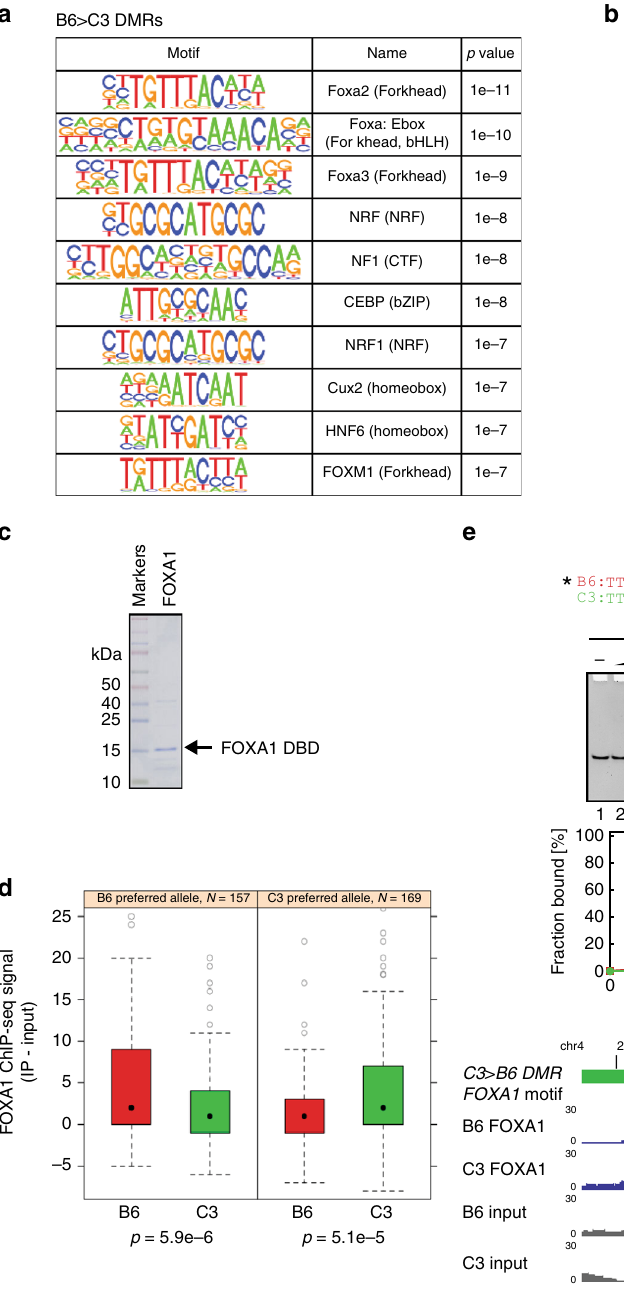
Fig. 4 SNVs at DMRs affect DNA-binding activity of a tissue-speci fi c transcription factor. a Top 10 enriched TF motifs in B6 > C3 DSS DMRs (after expanding DMR size to a minimum of 401 bp) according to HOMER v4.9.1. b Top 10 enriched TF motifs in C3 > B6 DSS DMRs (after expanding DMR size to a minimum of 401 bp) according to HOMER v4.9.1 c Protein puri fi cation of FOXA1 DNA-binding domain (DBD). Puri fi ed FOXA1 DBD was analyzed by SDS-PAGE. The black arrow indicates FOXA1 DBD. d FOXA1 ChIP-seq signal at SNV-containing FOXA1 motifs. Occurrences of FOXA1 motifs (as de fi ned by HOMER motifs FOXA1.LNCAP or FOXA1.MCF7) within 100 nt of a DMR were categorized by whether the B6 or C3 allele was preferred according to the HOMER position weight matrix [PWM]. FOXA1 signal in the B6 and C3 animals is reported as input-subtracted ChIP-seq read count at 100 nt regions centered on the motif occurrences. The box depicts the 25th to 75th percentiles, the black dot is the median, the whiskers extend to data points up to 1.5*IQR beyond the box, and open gray circles are data points outside the whisker range. Reported p values are from Mann – Whitney test. e , f DNA-binding analyses of FOXA1 DBD with SNV-containing DNAs. The genomic positions and DNA substrates are indicated at the top of each panel with a representative FOXA1 motif. The position of the SNV is highlighted with light blue boxes. The band intensities were calculated using ImageJ software. Totally, 20 bp double-stranded DNAs were incubated with the FOXA1 DBD. The concentration of FOXA1 DBD was as follows: 0 μ M, lanes 1,6; 0.15 μ M lanes 2,7; 0.3 μ M, lanes 3,8; 0.6 μ M, lanes 4,9; 1.2 μ M, lanes 5,10. The protein – DNA complex was separated by native-polyacrylamide gel